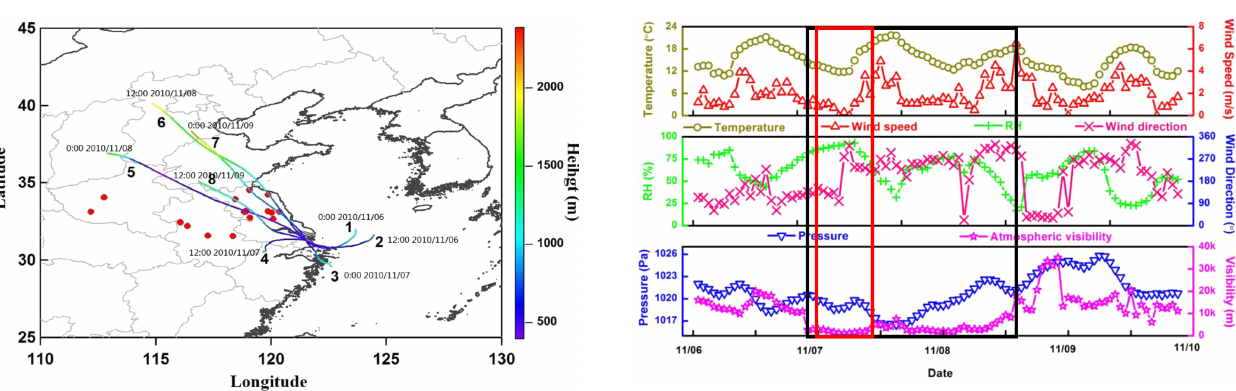
Figure 1. Agricultural fire scattering areas and air mass transport pathways across these regions. All red spots represent biomass burning sites on 7 November measured from MODIS satellite. Start- ing time (LT) is labeled in the figure.